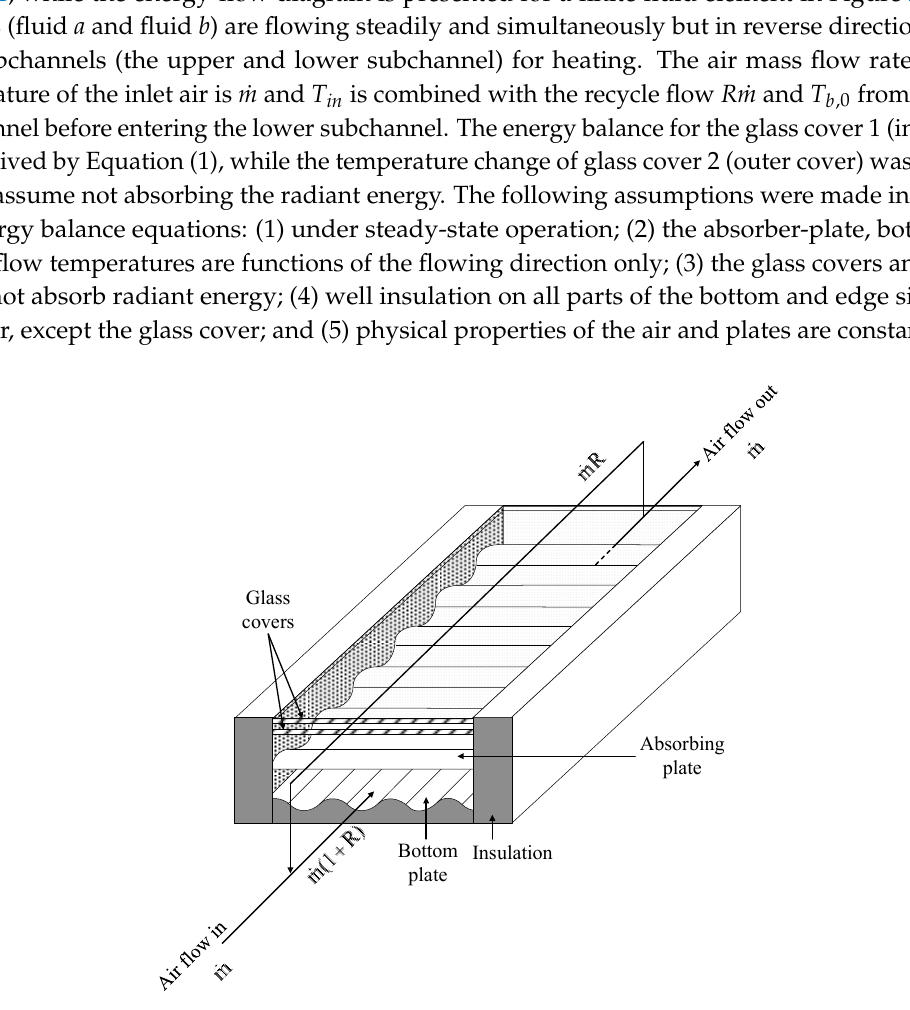
At steady state, Energy in = Energy